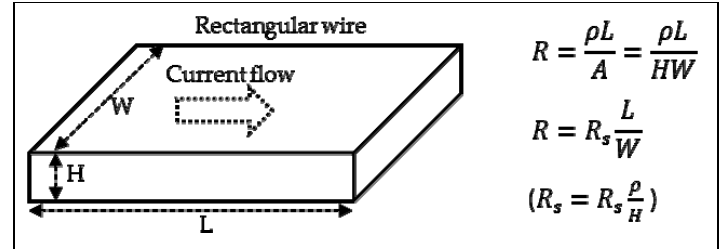
Figure 4. Wire resistance ( R ) and sheet resistance ( R s ).